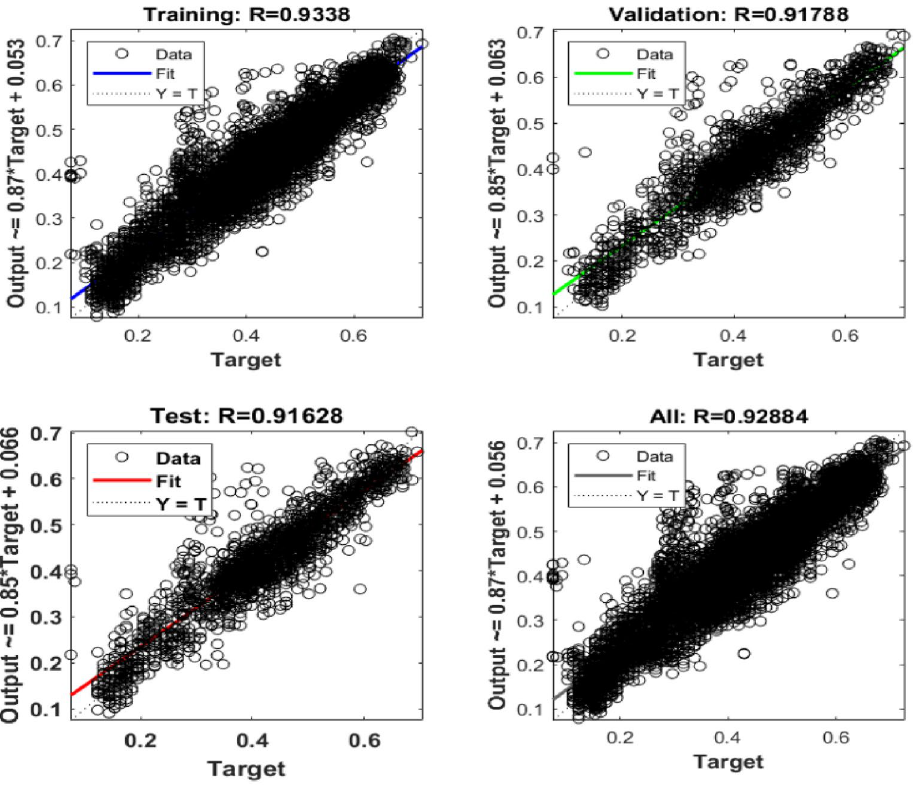
Figure 12. Best fit output of ANN